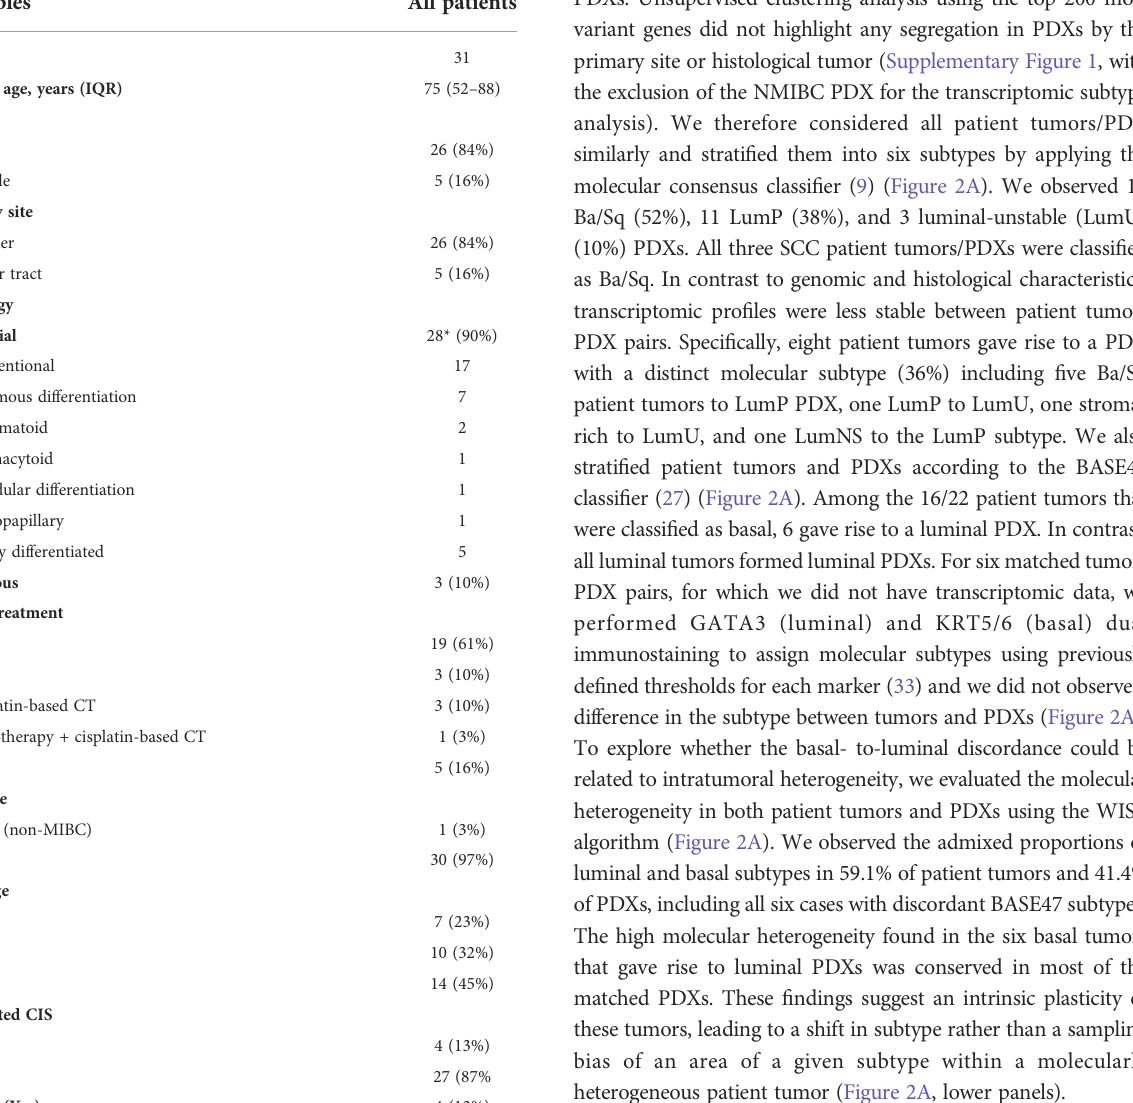
TABLE 1 Clinicopathological characteristics of the samples used for patient-derived xenograft.